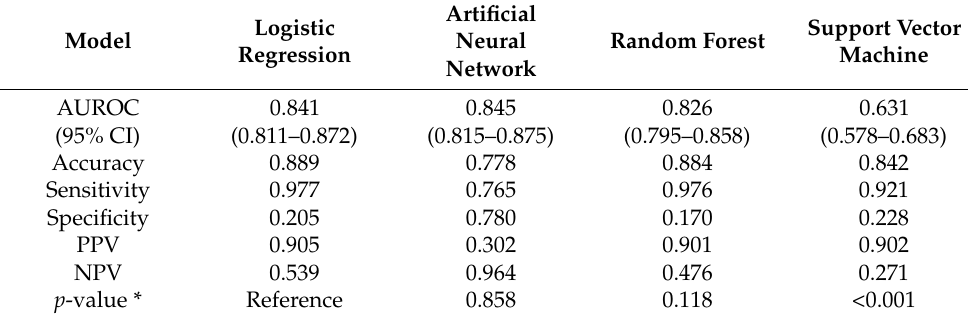
Table 2. Prediction performance of ML models on the test set.